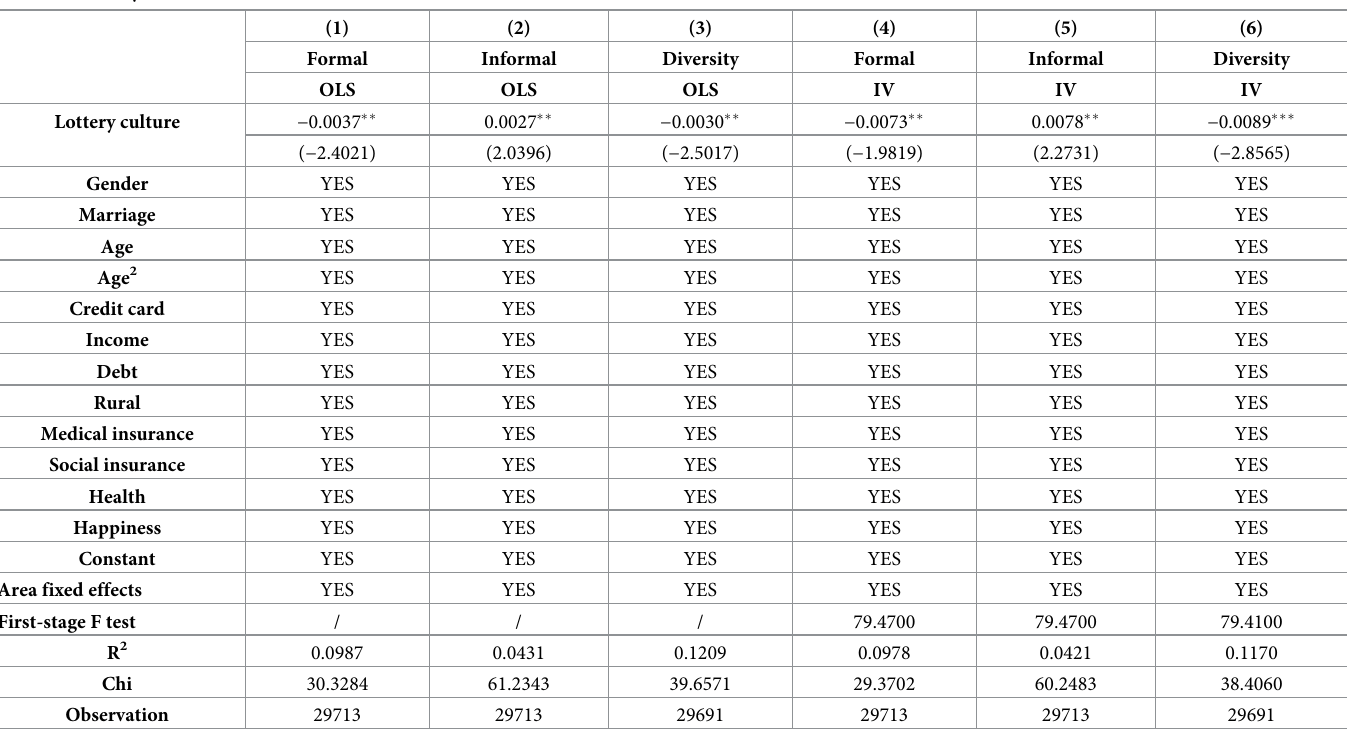
Table 3. “Lottery culture” and household financial